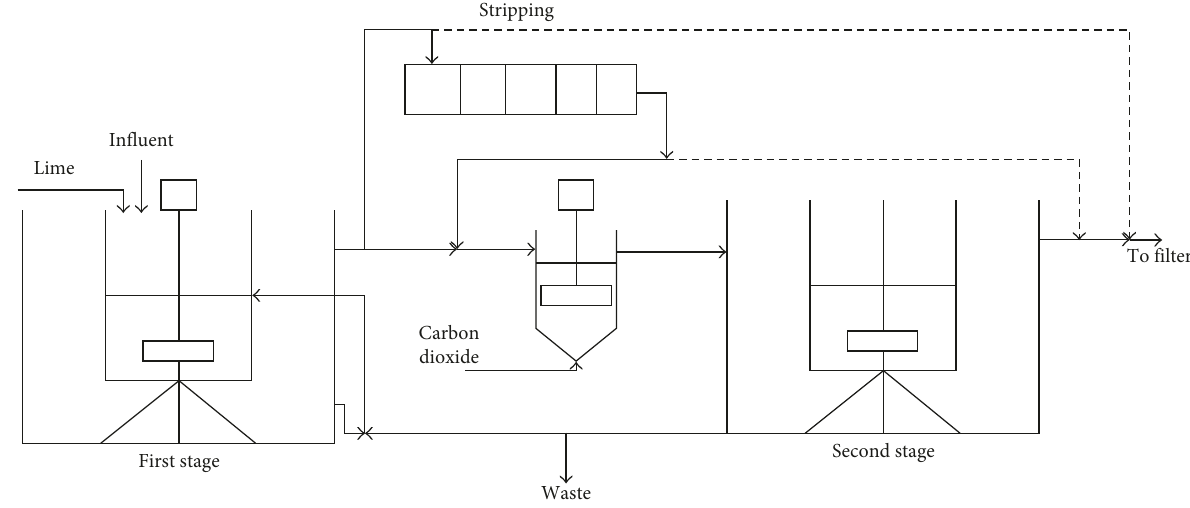
Figure 1: Schematic ammonia stripping process for leachate-polluted groundwater